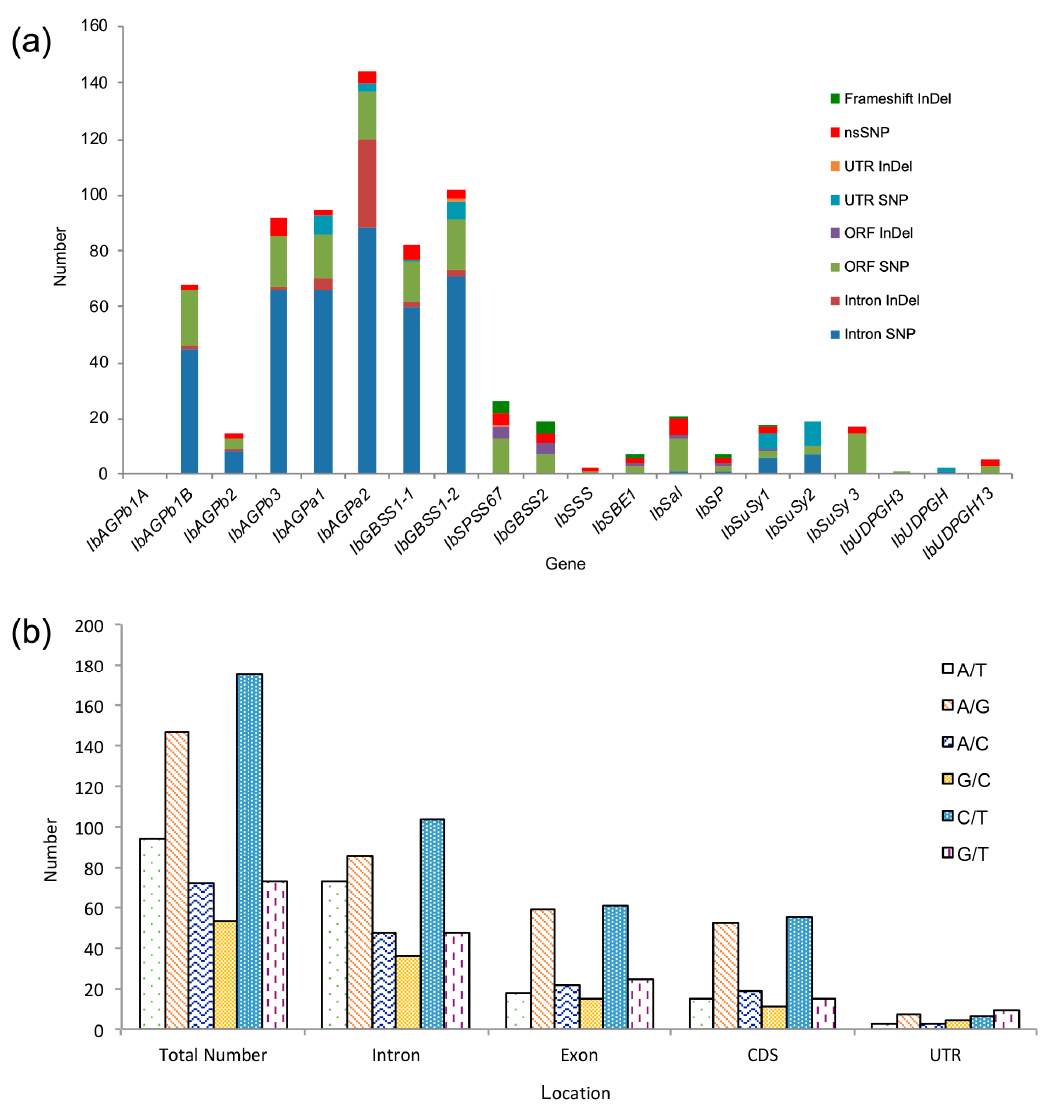
Figure 2. Summary of the single nucleotide polymorphisms (SNPs) and insertions/deletions (InDels) identified in this study. ( a ) Summary of the number of SNPs and InDels detected in the 20 genes. ORF, open reading frame; UTR, untranslated region. ( b ) Number of substitutions in the detected SNPs. CDS, coding sequence;